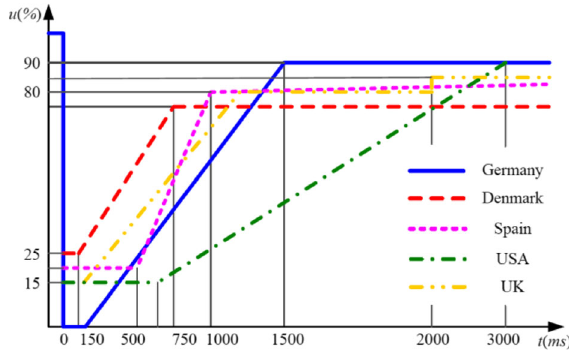
Fig. 2 Limits zone supported by the wind system during voltage dips in some